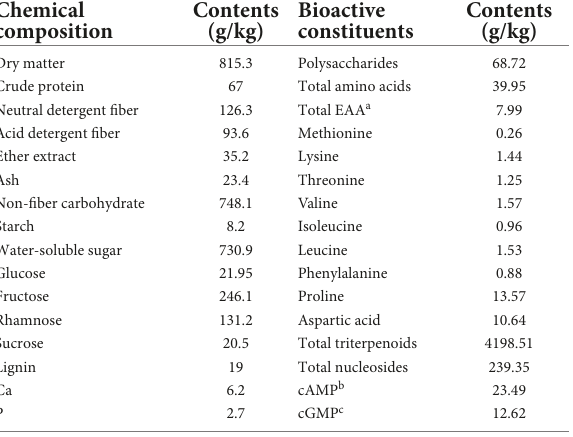
TABLE 2 Chemical composition and bioactive constituents of the jujube powder (DM